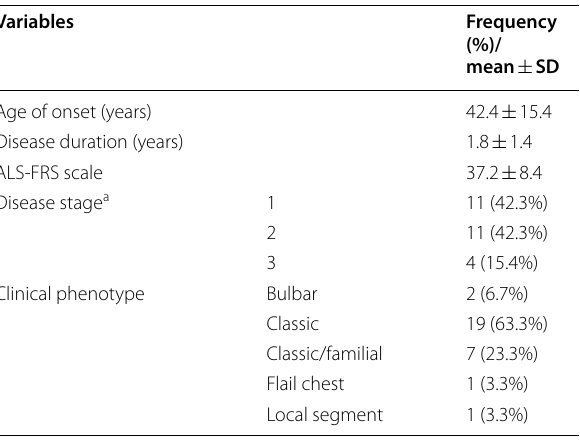
Table 4 Neurological clinical results among 30 ALS